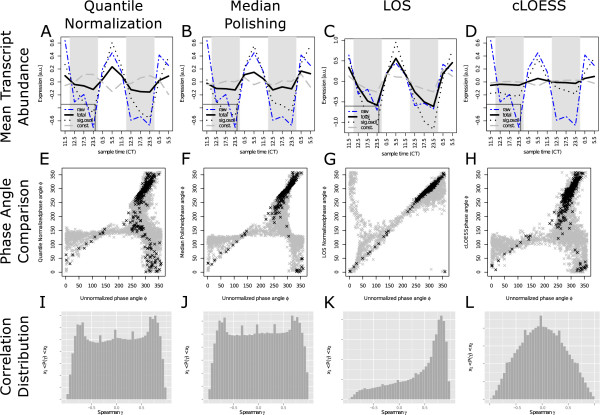
Normalization changes phase angles and expression correlation. Systematic comparison of important properties of the expression profile set after normalization with different methods. Columns one to four correspond to the methods quantile normalization, median polishing, LOS, and cLOESS, respectively. Rows one to three correspond to plots of prominent average expression profiles, expression phase comparisons, and pairwise correlation distributions. The mean expression profiles for different gene groups illustrate the impact of normalization methods. A comparison of the unnormalized mean expression profile of all genes (dashed blue) with the normalized mean over all genes (black solid), significantly oscillating genes (posc < 0.05 in unnormalized data - black dotted) and not oscillating genes (posc > 0.05 in unnormalized data - gray dashed) is shown in panel A to D. The time of maximal expression in oscillatory profiles, measured using the Fourier transformation, is frequently altered by the normalization method. Panel E to H show the comparison between expression phases observed in the unnormalized (x-axis) versus normalized (y-axis) data. Profiles with significantly oscillating expression (posc < 0.05) are shown in black, whereas weak or non-oscillators are shown in gray (posc > 0.05). The histogram of pairwise Spearman correlation coefficients between expression profiles as proxy of the diversity of the global expression landscape is shown in panels I to L.